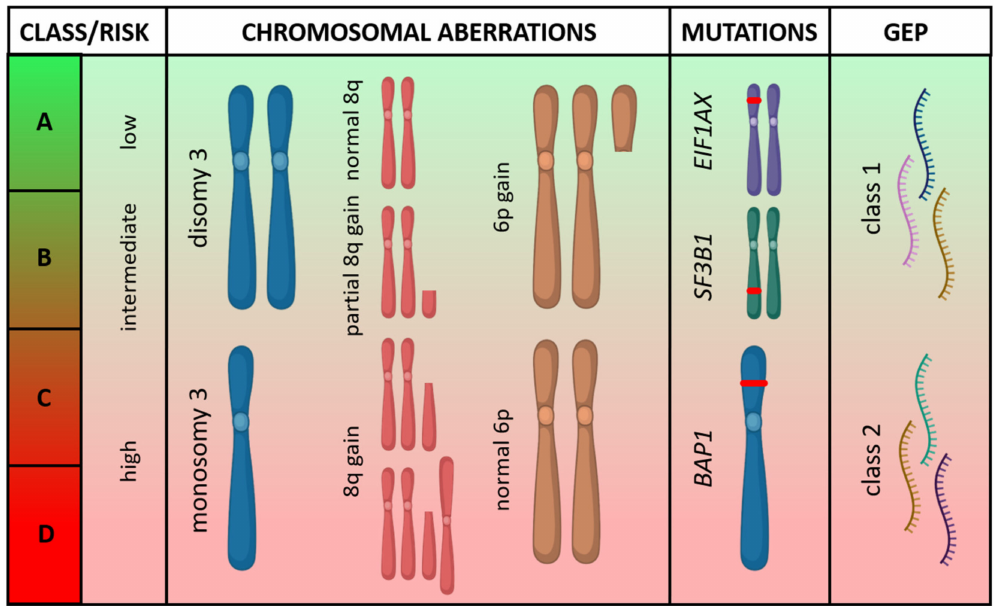
Figure 2. Overview of genetic prognostic biomarkers in primary posterior uveal melanoma. Based on their increasing risk of metastasis, four molecular subsets ( A – D ) are depicted based on their chromosomal aberrations, secondary driver mutations, and gene expression profile (GEP). (Figure was created with PowerPoint and